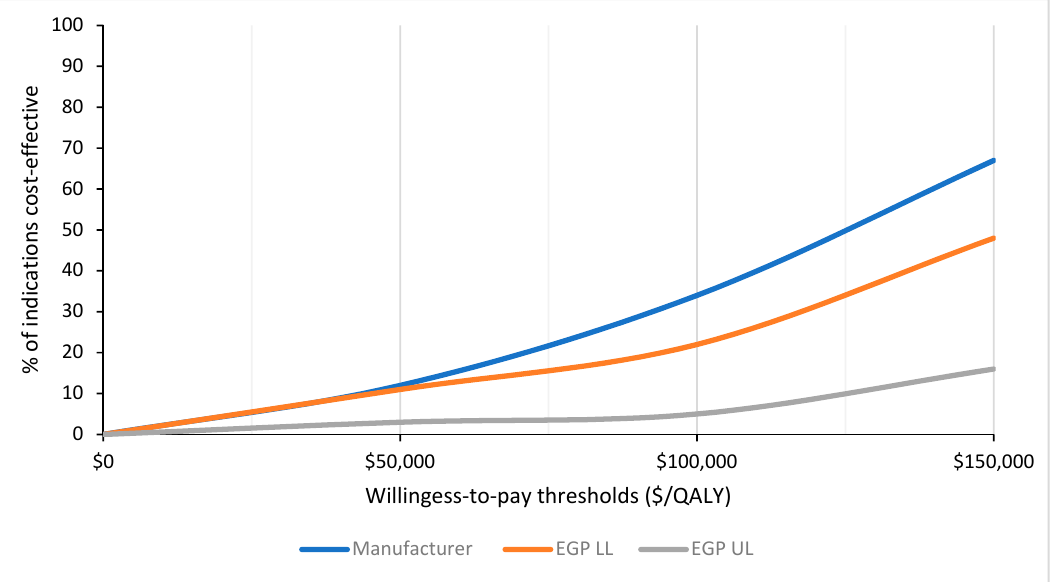
Figure 4. Percentage of cost-effectiveness indications, at varying willingness-to-pay thresholds, based on incremental cost-effectiveness ratios generated from the manufacturer-submitted and EGP-re-an- alyzed economic models. EGP—economic guidance panel; LL—lower limit; UL—upper limit; ICE— incremental cost-effectiveness ratio; QALY—quality-adjusted life year.